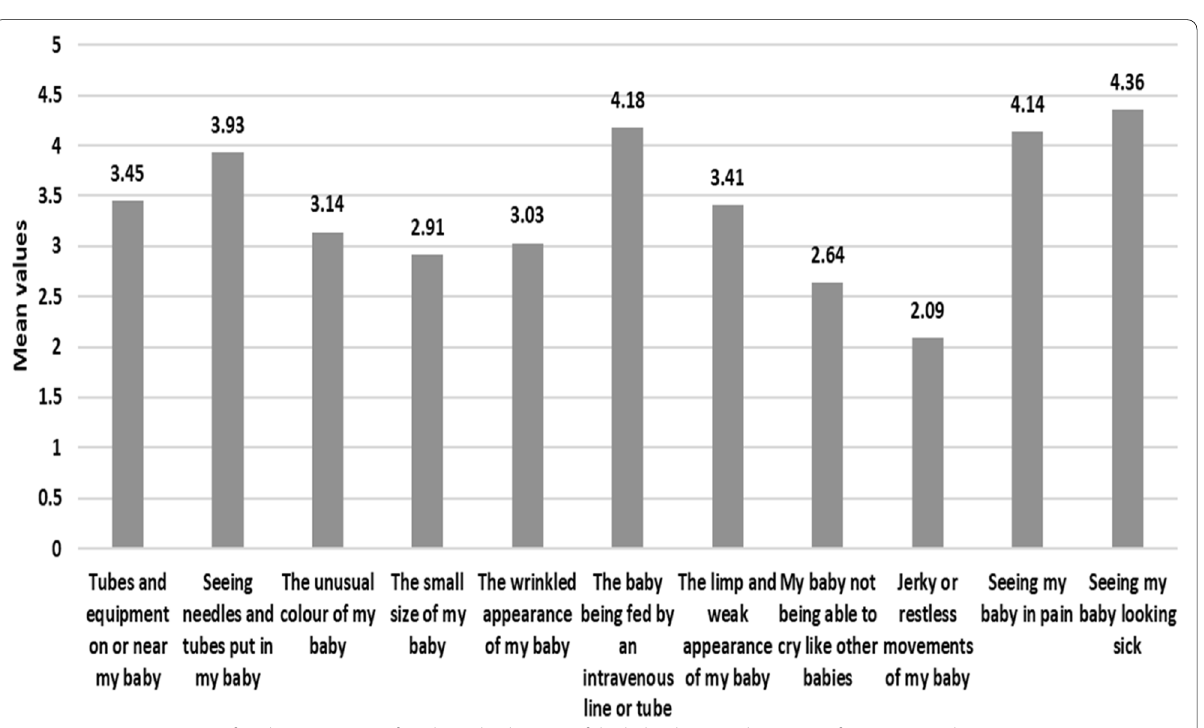
Fig. 2 Mean Stress Scores of each component of Looks and Behaviour of the baby domain (domain 2) of PSS: NICU